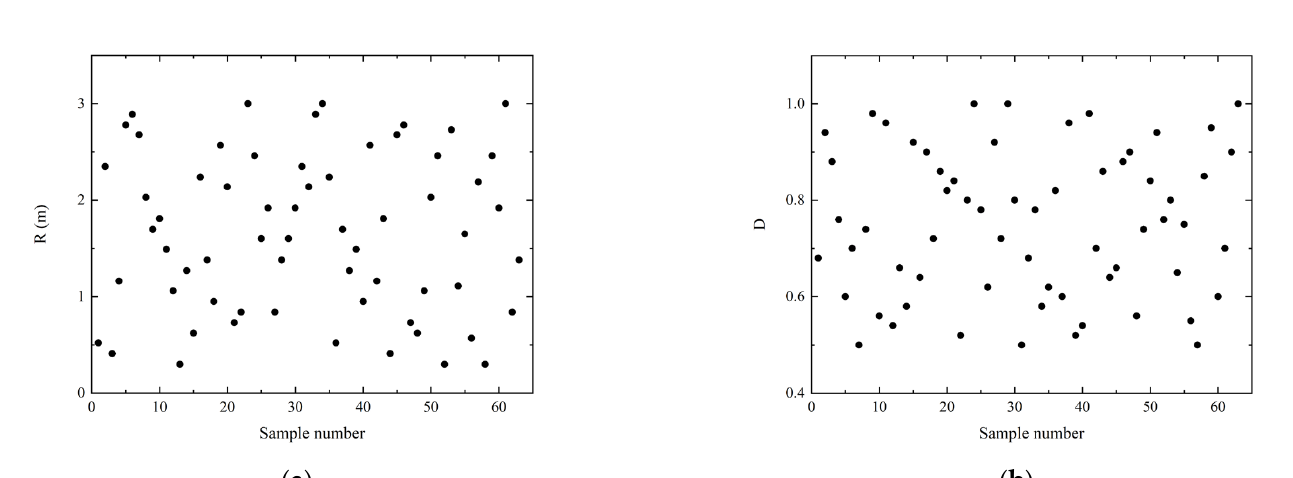
( c ) Figure 6. Sample scatter diagrams. ( a ) radius. ( b ) the ratio of draft radius. ( c ) C PTO . According to the sample points parameters, the simulation models are established. The wave excitation force, additional mass and radiation damping are calculated for each sam- ple point based on ANSYS-AQWA. According to Equation (17), the mean annual power of each sample point was calculated, and the scatter diagrams are shown in Figure 7.